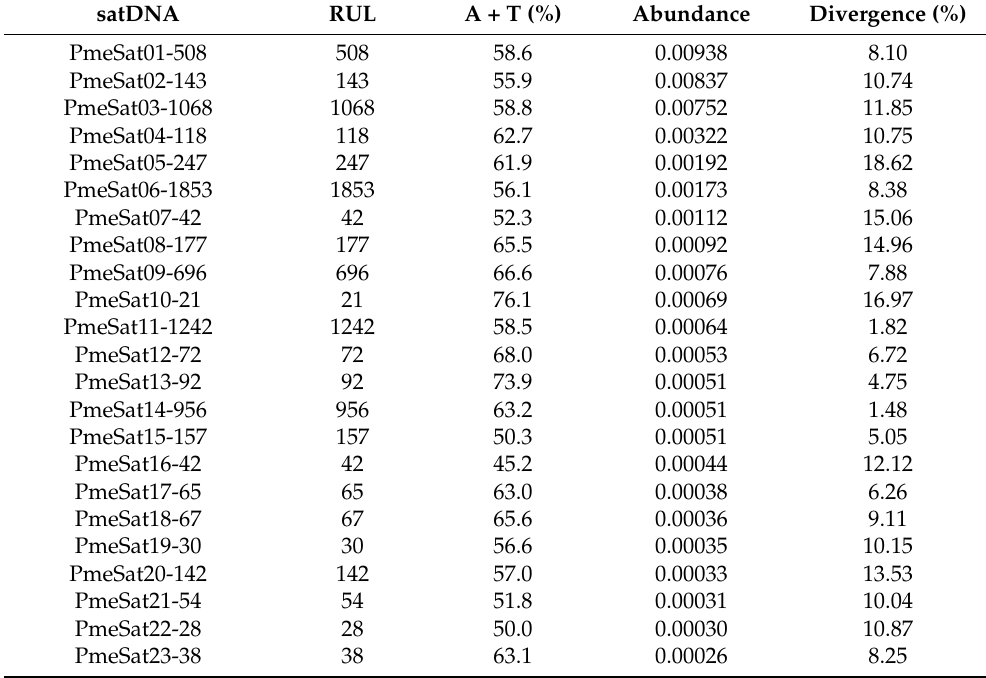
Table 1. Main features of Piaractus mesopotamicus